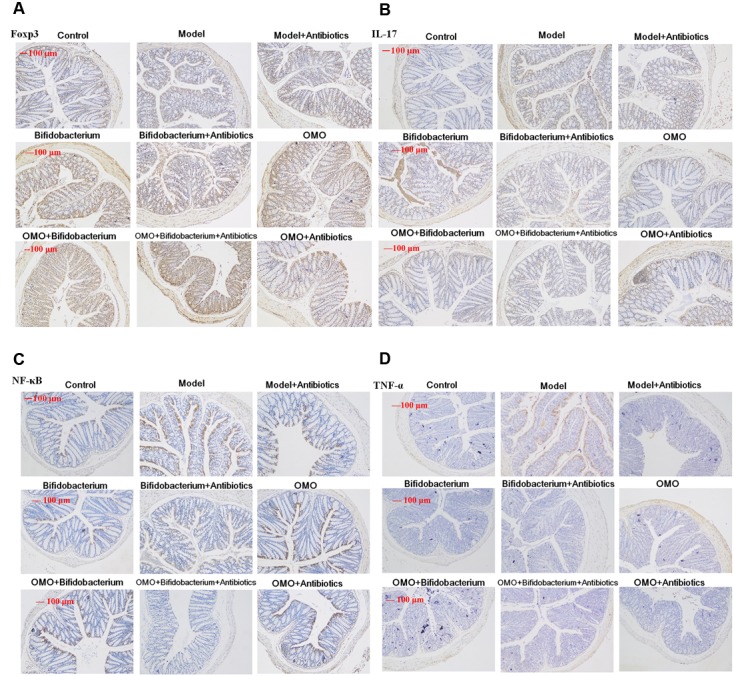
Immunohistochemistry staining of Foxp3 (A), IL-17 (B), NF-κB p65 (C), and TNF-α (D) in the colons of different experimental groups in high-dose broad spectrum antibiotics and TNBS-induced IBD mice after treatment with OMO.